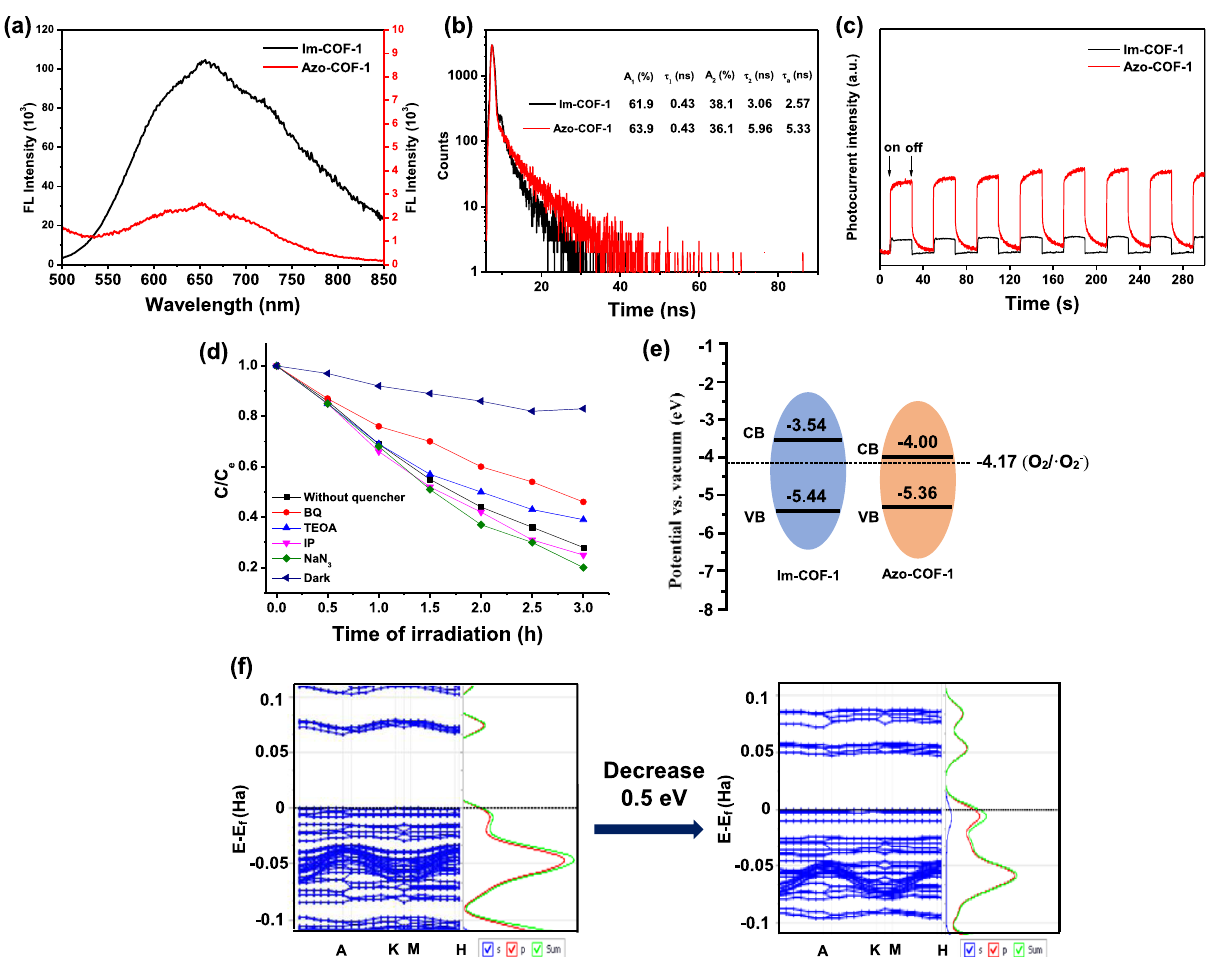
Fig. 6 Characterization for the photocatalytic mechanism study. Comparisons of ( a ) steady-state PL spectra excited at 375 nm, ( b ) time-resolved transient PL decay curves, and ( c ) transient photocurrent response measurements between Im-COF-1 and Azo-COF-1. d Photocatalytic degradation of RhB by Azo-COF-1 in the presence of different scavengers. e , f DFT calculations of band structures of Im-COF-1 and